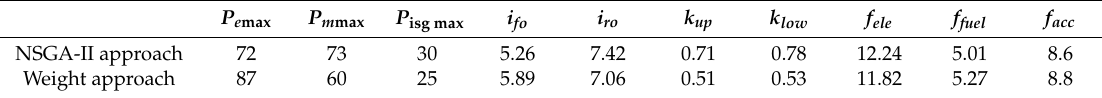
The best compromise solution obtained by using the NSGA-II algorithm and the weight